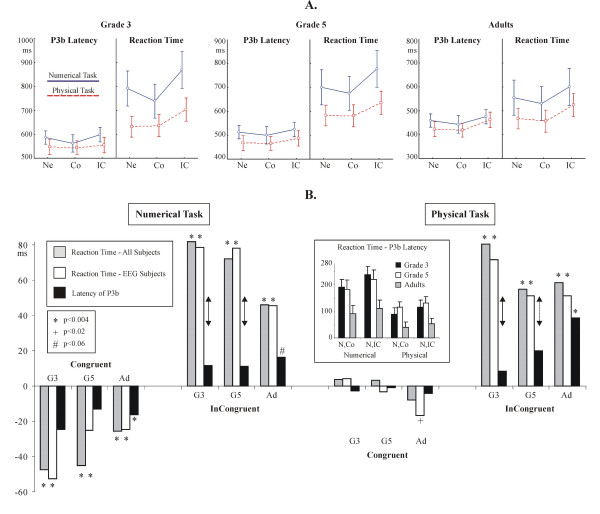
(A) Congruency effects in the P3b latency and in reaction time in subjects accepted for EEG analysis. Conditions are represented on the X axis: Ne: neutral. Co: Congruent. IC: Incongruent. (B) Facilitation and interference effects on the reaction time (RT) and on the latency of the P3b ERP component in grade 3 (G3), grade 5 (G5), and in adults (Ad). The RT of all 46 subjects and of the 30 of subjects accepted for EEG analysis is shown separately. Facilitation and interference values were computed as Congruent minus Neutral, and Incongruent minus Neutral values. The deviation of the difference values from zero was tested by two-tailed one-sample t-tests against zero. Results of these tests are represented by "*", "+" and "#" signs (see legend). Double-headed arrows denote the cases when interference effects on the latency of the P3b and the on RT were significantly different (see text for details). The insert shows the difference between the RT and P3b latency in milliseconds (with standard errors). X axis of the insert: "N,Co": the average of the neutral and congruent conditions. "N,IC": the average of the neutral and incongruent conditions.